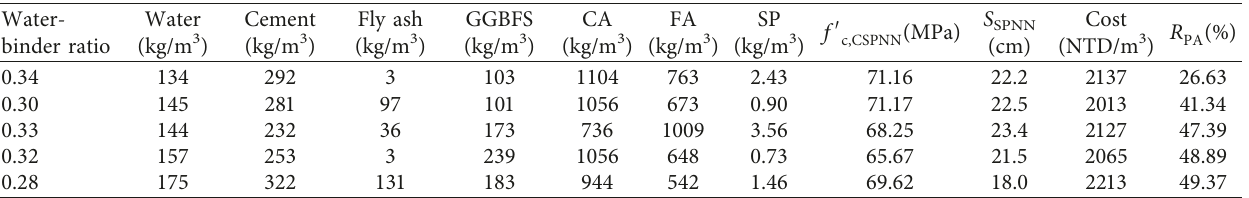
Table 13: Concrete mixture proportioning samples for compressive strength � 700kg/cm 2 and 2000NTD/m 3 < cost ≤ 2250NTD/m 3 . Water- binder